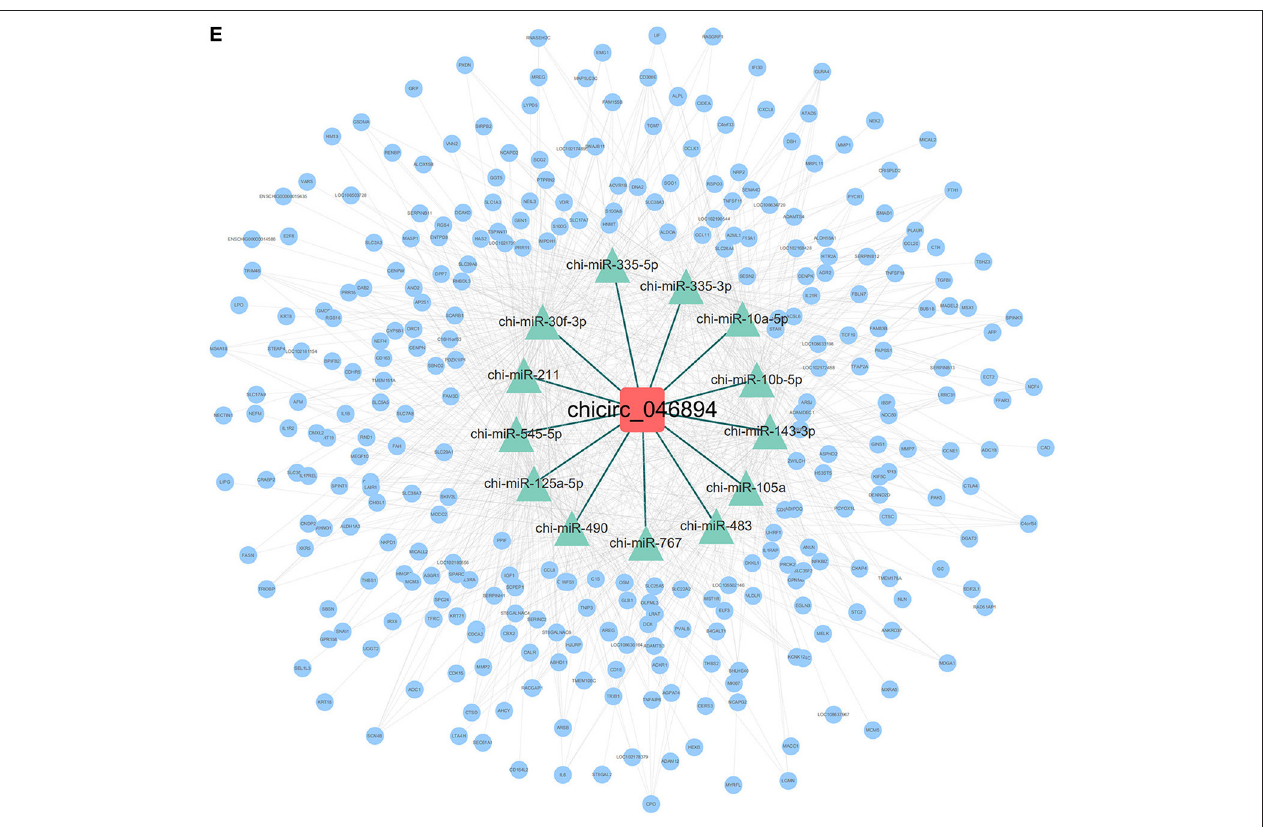
cytokine–cytokine receptor interactions (33). The most enriched KEGG pathway cytokine–cytokine receptor interaction was also enriched by the mouse lung DGEs that infected with P. multocida (31). Together, these results indicate that P. multocida infection can induce the extensive cytokine changes that participated in the mouse, chicken, and